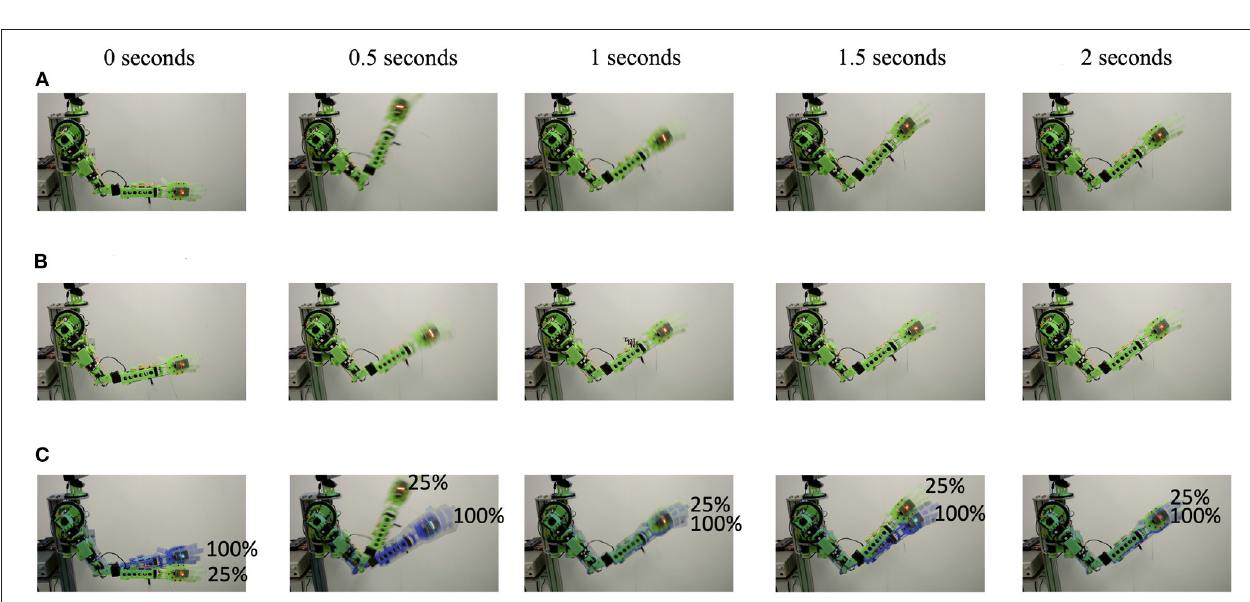
FIGURE 6 | The composite rubber/nylon tendons provide an increase in stiffness with increase in co-contraction on the agonist-antagonist actuators of the GummiArm v1.0. The plot shows passive joint deflection (y-axis) of the elbow joint from applying an external torque (x-axis) under quasi-static conditions, for different values of commanded co-contraction. Deflection corresponding to elbow extension. The mean over 3 repetitions shown as solid lines, while open circles indicate data points.